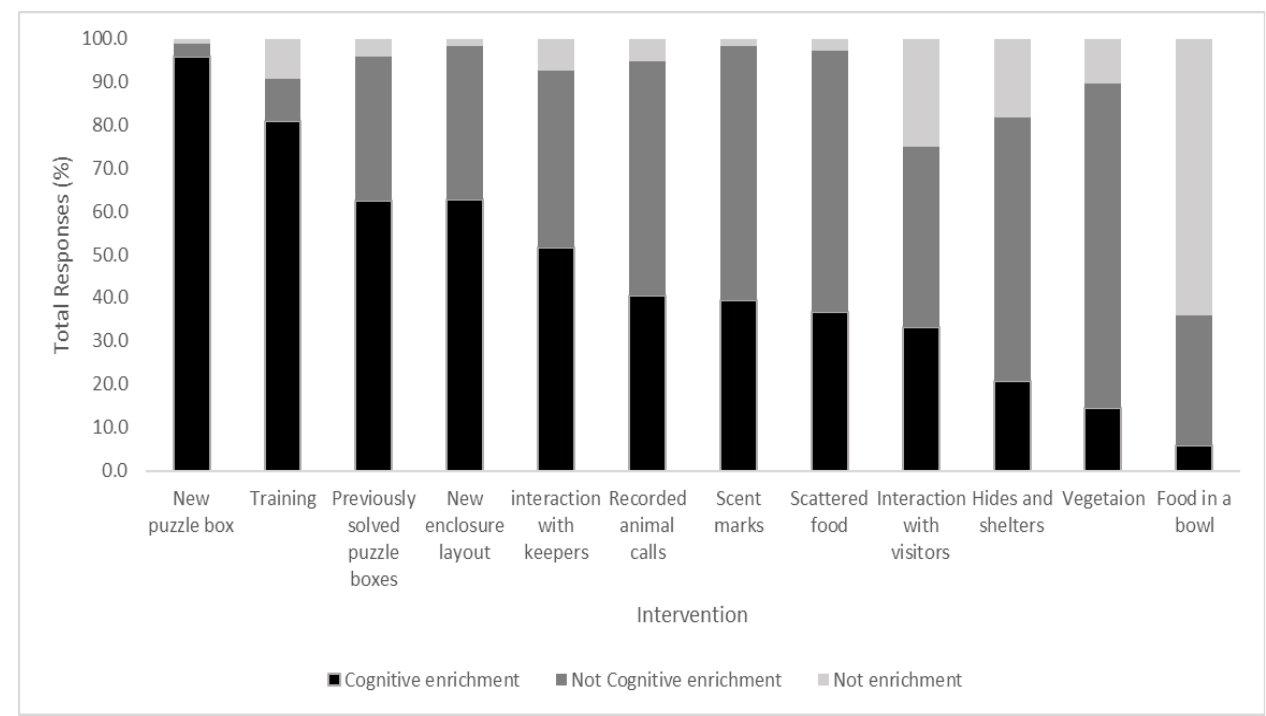
Figure 1. Percentage of respondents who classed each intervention as ‘Cognitive enrichment’, ‘Not Cognitive enrichment’ or ‘Not enrichment’.